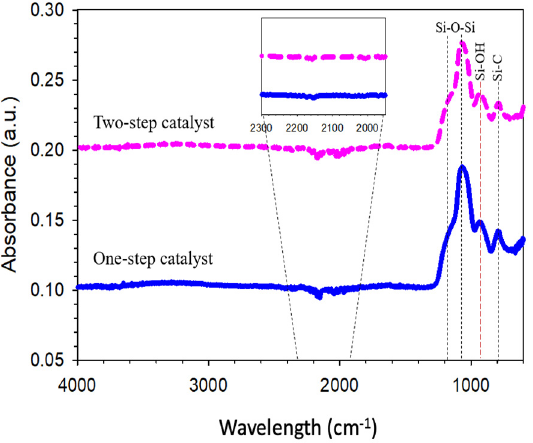
Figure 2. FTIR spectra of one-step catalyst (citric acid) and two-step catalyst (acid-base) xerogels calcined at 175 °C.